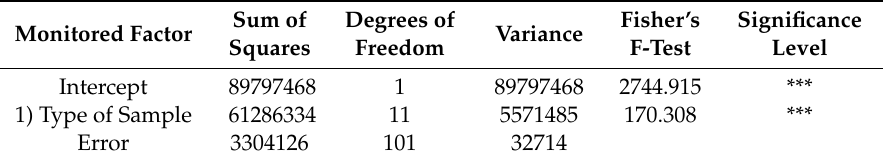
Table 16. Statistical evaluation of the e ff ect of the factors and their interaction on the minimum bend radius at the yield point ( R minB ) for aspen and NWC on top.